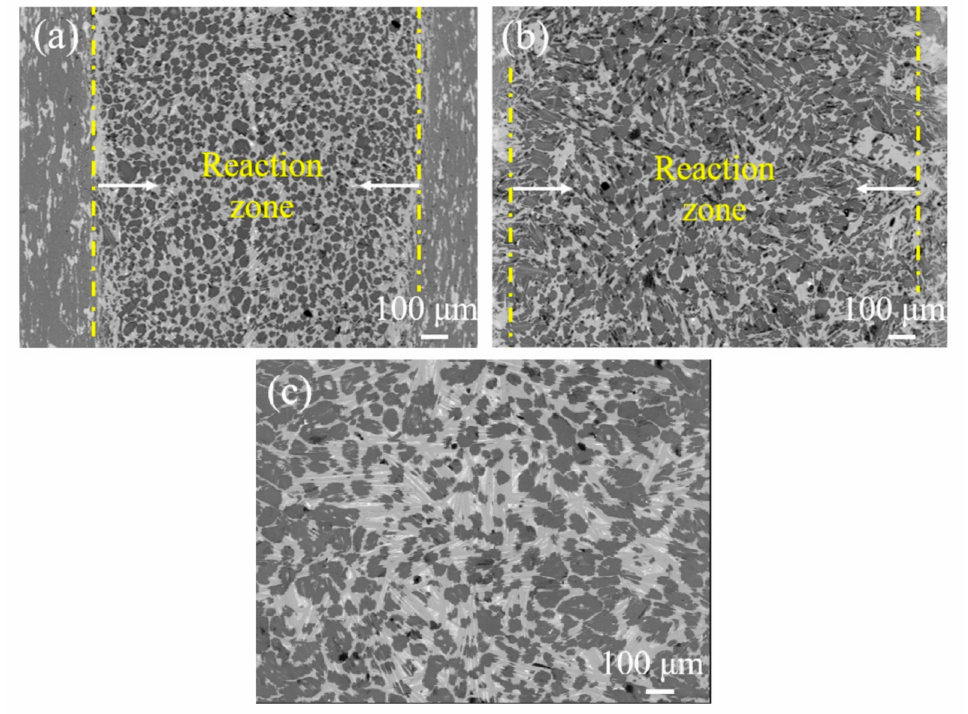
Figure 8. Microstructure of the diffusion bonding joint with the interfacial roughness of 800#. ( a ) 440 ◦ C ( b ) 460 ◦ C ( c ) 480 ◦ C.